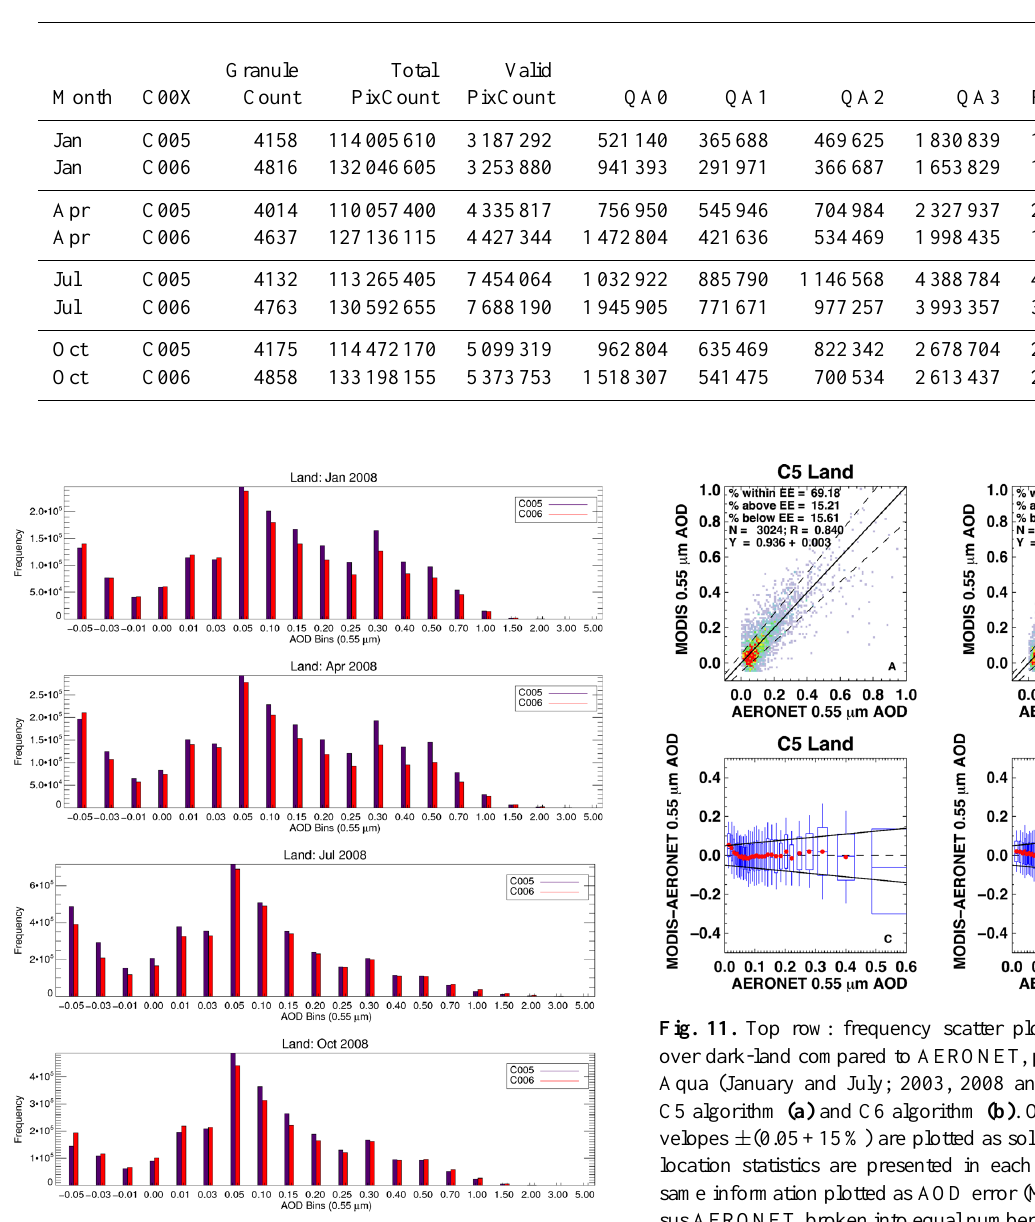
Table 2. C5/C6 Comparison of DT-land statistics for Aqua; January, April, July and October 2008.